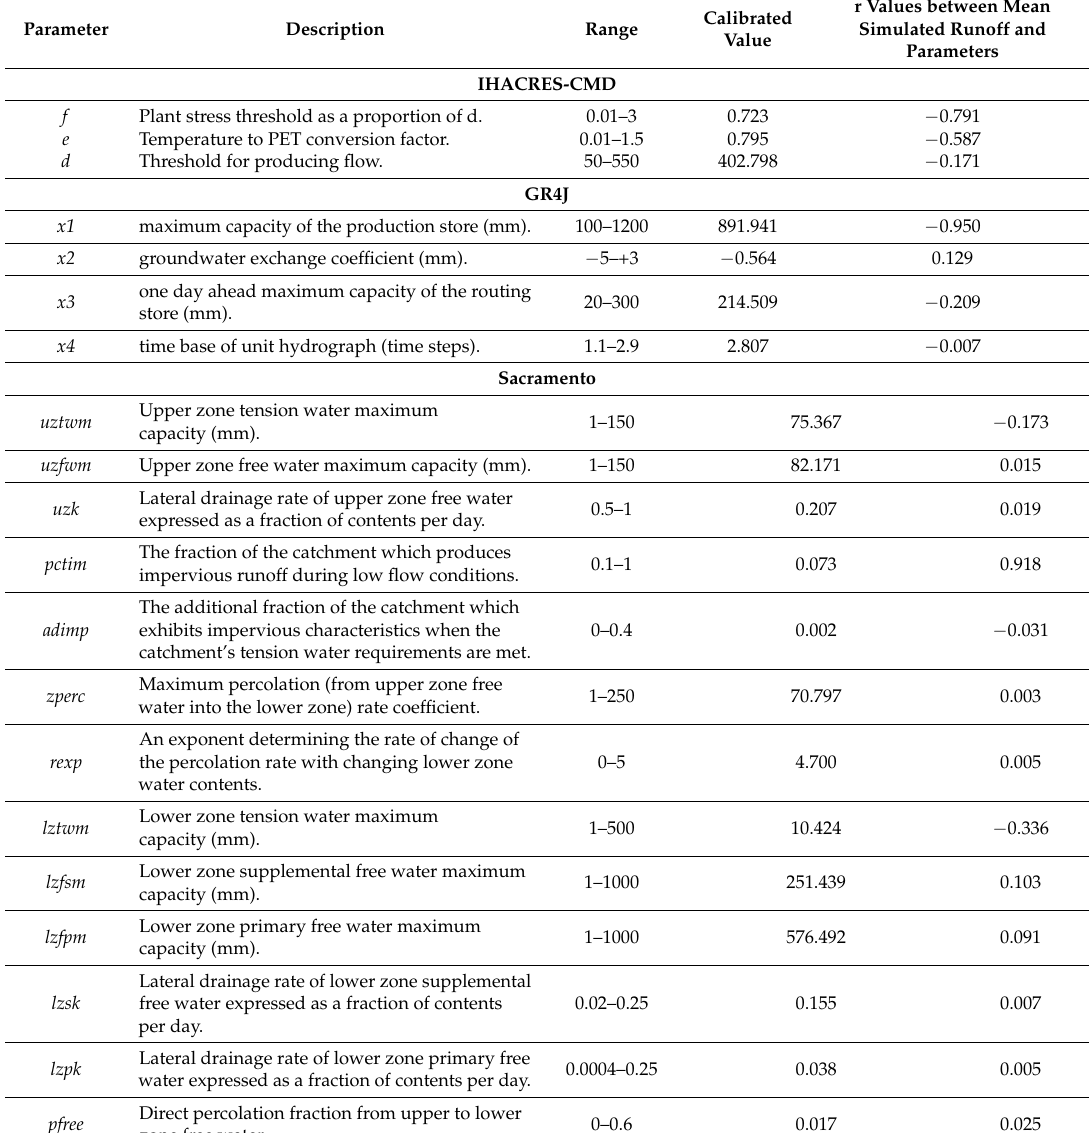
Table 1. Parameter descriptions and correlation coefficients ( r ) with simulated runoff from 10,000 model runs. Parameter Description Range